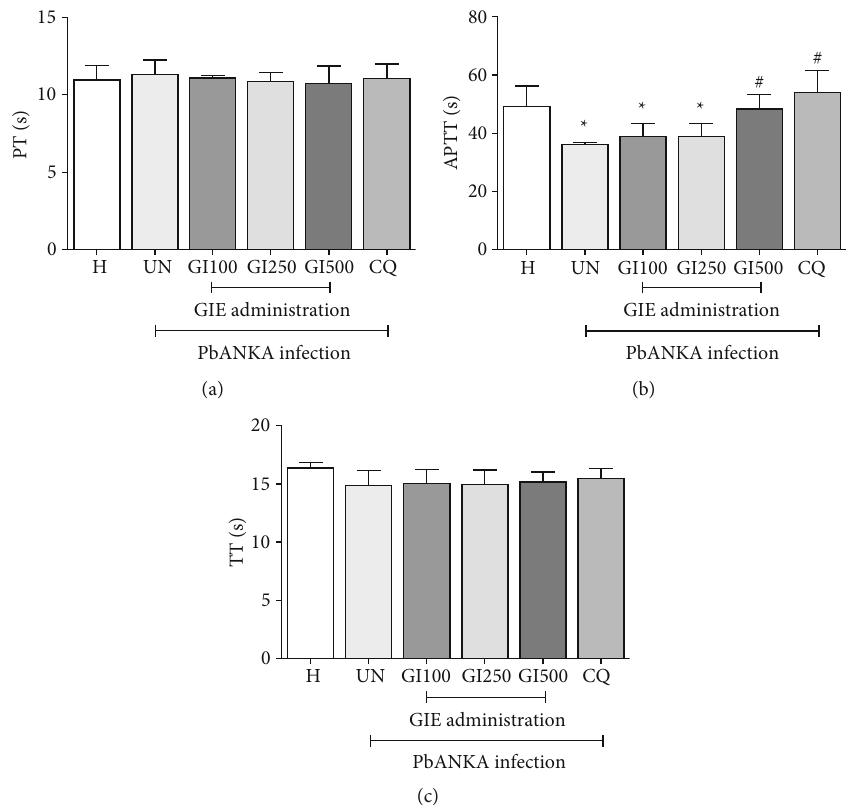
Figure 3: E ff ect of GIE on blood coagulation parameters in PbANKA-infected mice. Groups of ICR mice were inoculated with 1 × 10 7 parasitized RBC by intraperitoneal injection. GIE (100, 250, and 500 mg/kg) was given orally by gavage for 4 consecutive days. Blood coagulation parameters, including (a) PT, (b) APTT, and (c) TT, were measured using an automated analyzer. The results were presented as mean ± SEM . H: healthy; UN: untreated; GI100, GI250, and GI500: GIE treatment at doses of 100, 250, and 500mg/kg; CQ: 10mg/kg of chloroquine. ∗∗ p < 0 : 01 compared to H. # p < 0 : 05 compared to